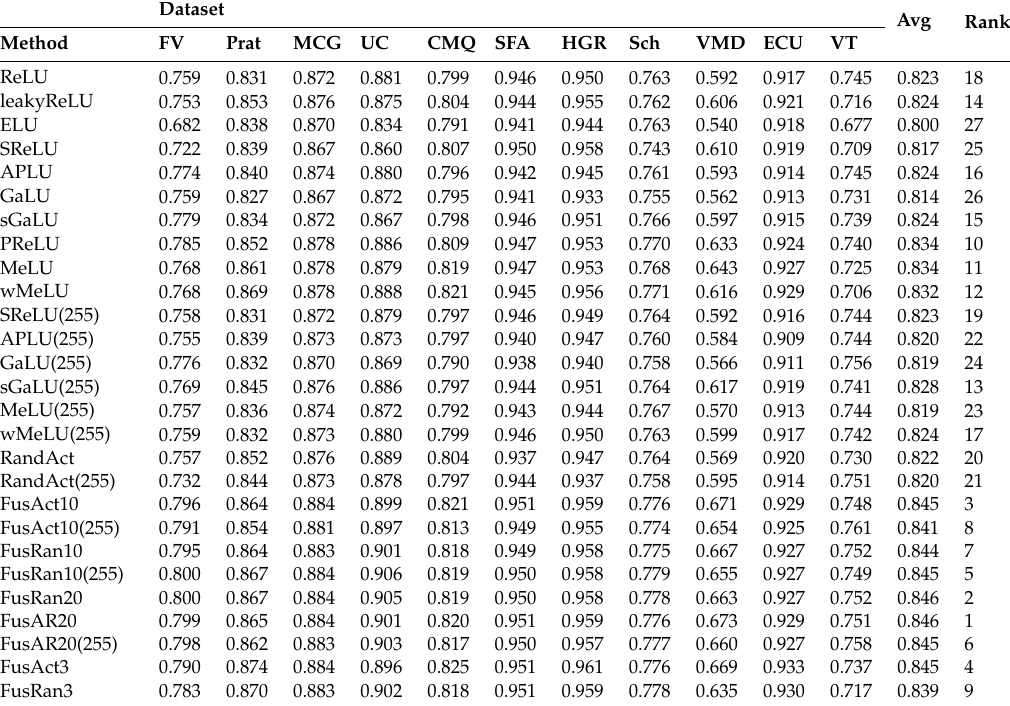
Table 6. Performance of the proposed approaches in the skin datasets